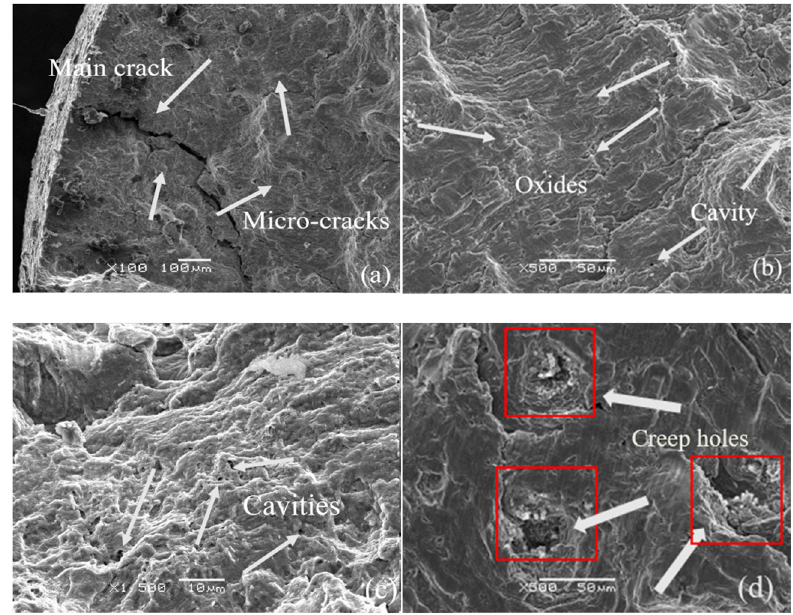
Figure 9: SEM fractographys of specimen of Δ ε mech /2 = 0.6% with 40 s hold time at ( a ) cracking initiation region, ( b ) propagation region, ( c ) fracture region, and ( d ) creep holes.